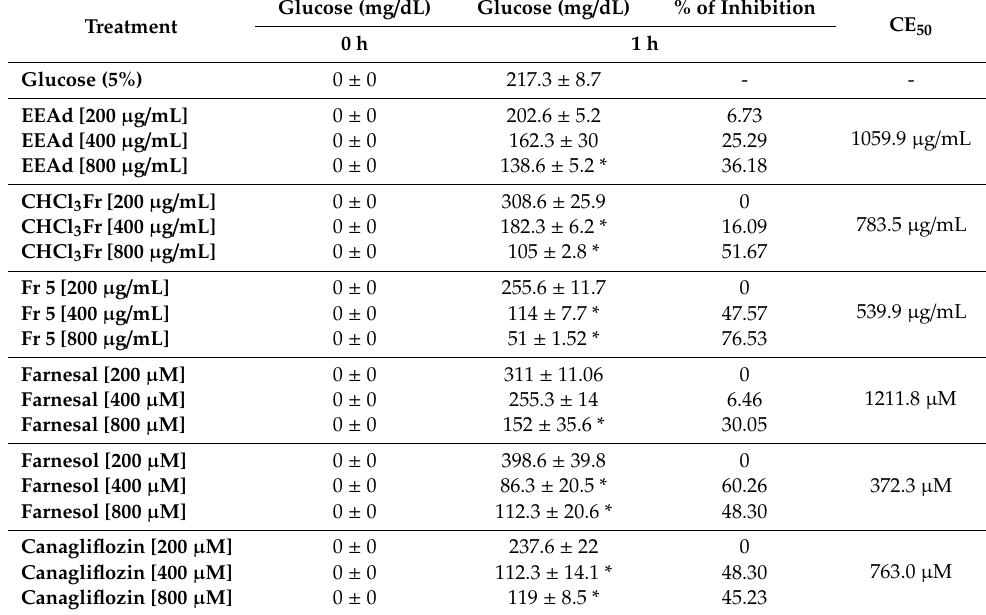
Table 3. Quantity of glucose measured in the external aqueous medium, percent inhibition, and CE 50 calculated after addition of treatments on intestinal glucose hydrolysis (IGA) inhibition test.